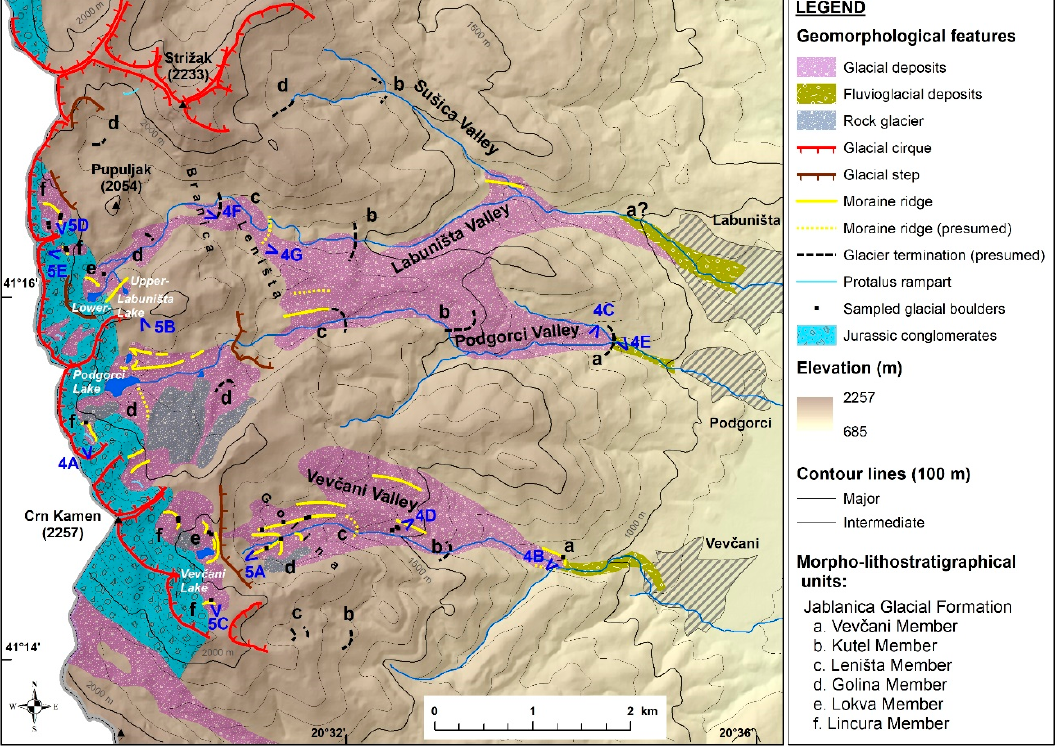
Figure 3. Glacial geomorphological map of the middle part of Jablanica Mountain. Blue numbers indicate the locations of the photos on Figures 4 and 5.